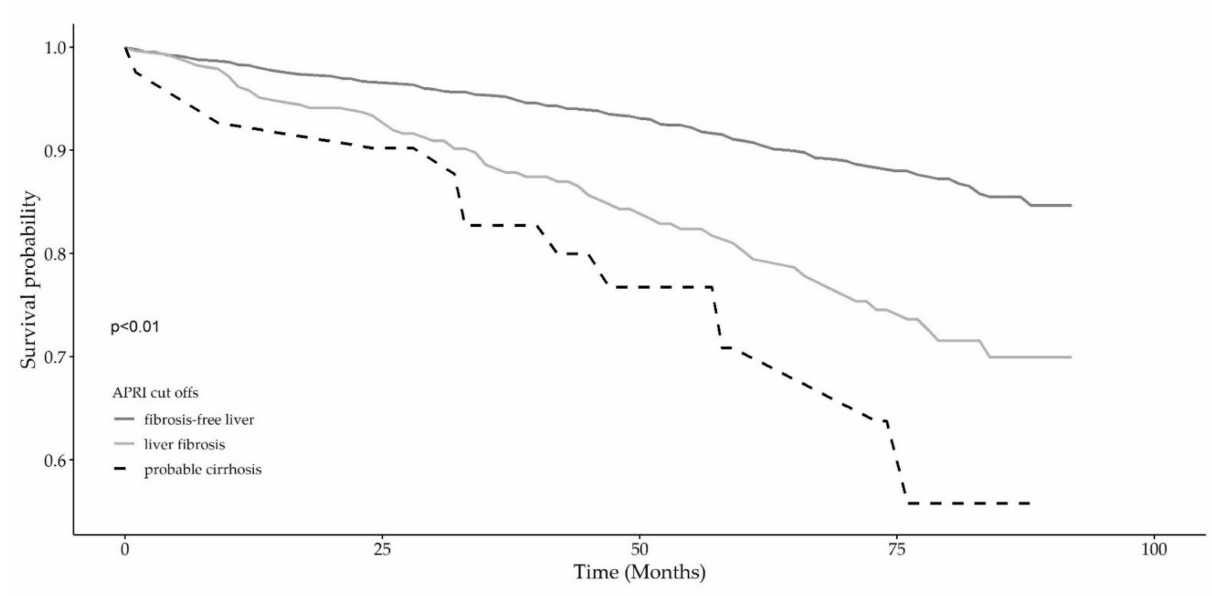
Figure 2. Kaplan–Meier survival curves for the probable fibrosis according to APRI scores: fibrosis-free (APRI < 0.50), liver fibrosis (APRI < 1.50) and probable cirrhosis (APRI ≥